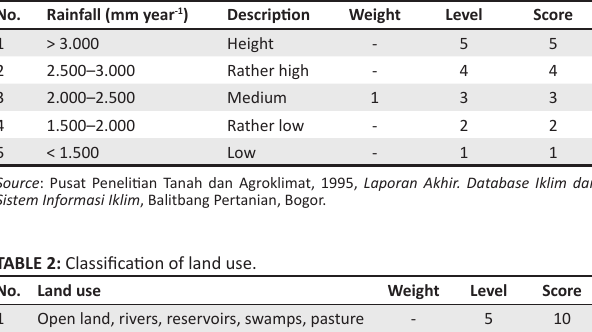
TABLE 1: Rainfall classification.